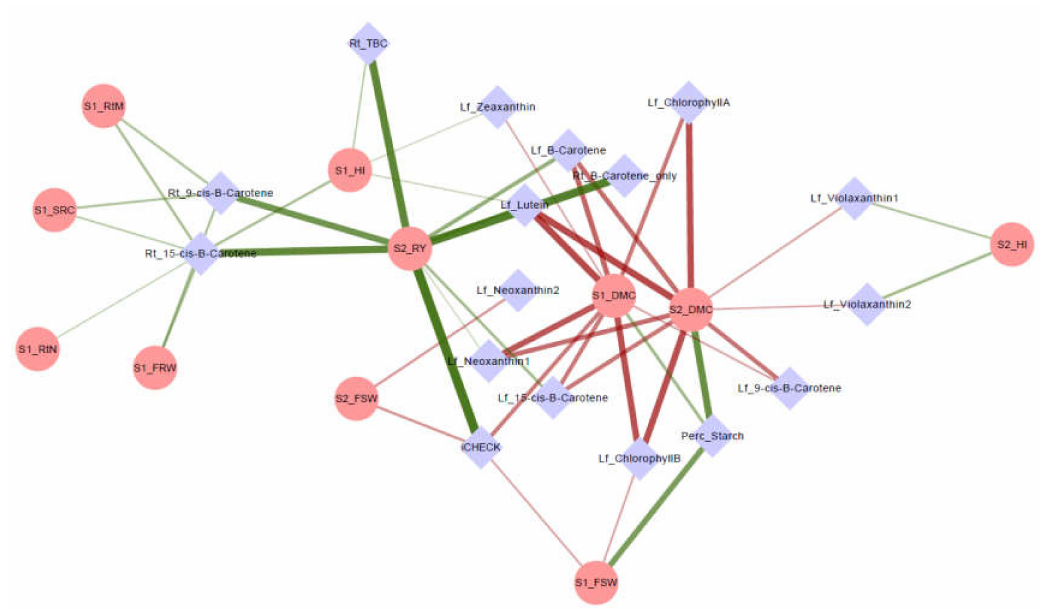
Figure 5. Correlations between agronomic traits and carotenoids. Red circular nodes are agronomic traits, while purple diamond nodes are metabolites. Green lines represent positive correlations, while red lines represent negative correlations. The thickness of the lines reflects the strength of the correlation. Spearman correlation cuto ff are values greater than 0.5 or less than − 0.5 (Rt = roots, Lf = leaf, S1 = season 1, S2 = season